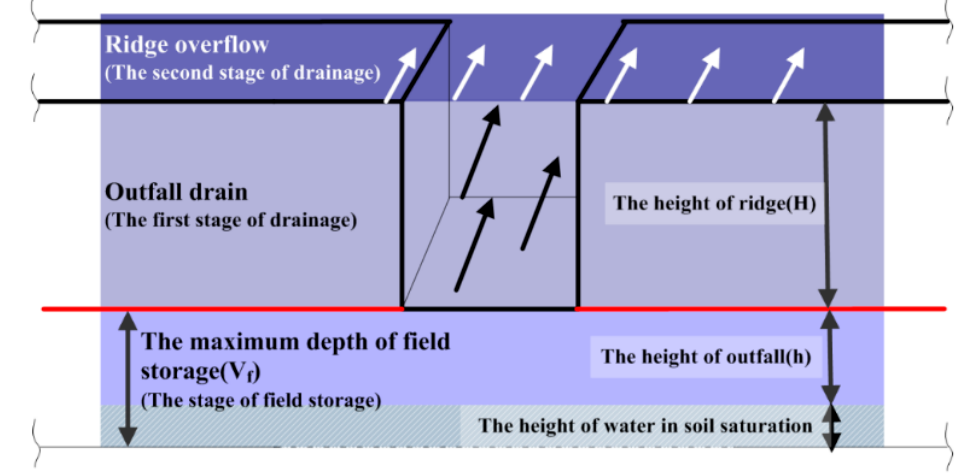
Figure 5. Two-way drainage stages in the paddy field. Table 3. Ponding depth during the first crop season of paddy rice in Taiwan.